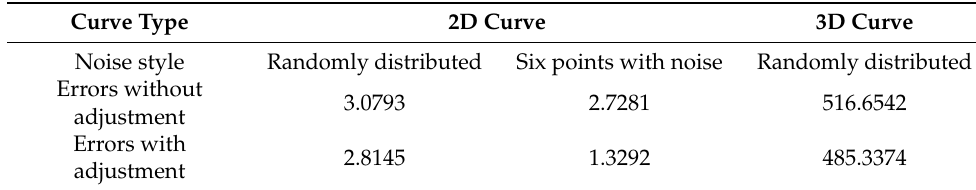
Table 2. Errors of curve fitting with/without the adjustment of abnormal samples.